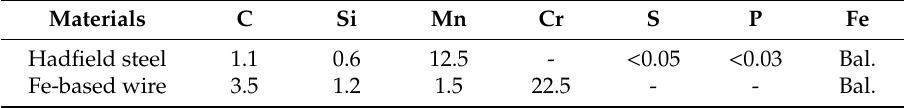
Table 1. Chemical composition of the Hadfield steel and the Fe-based wire (wt.%). Materials